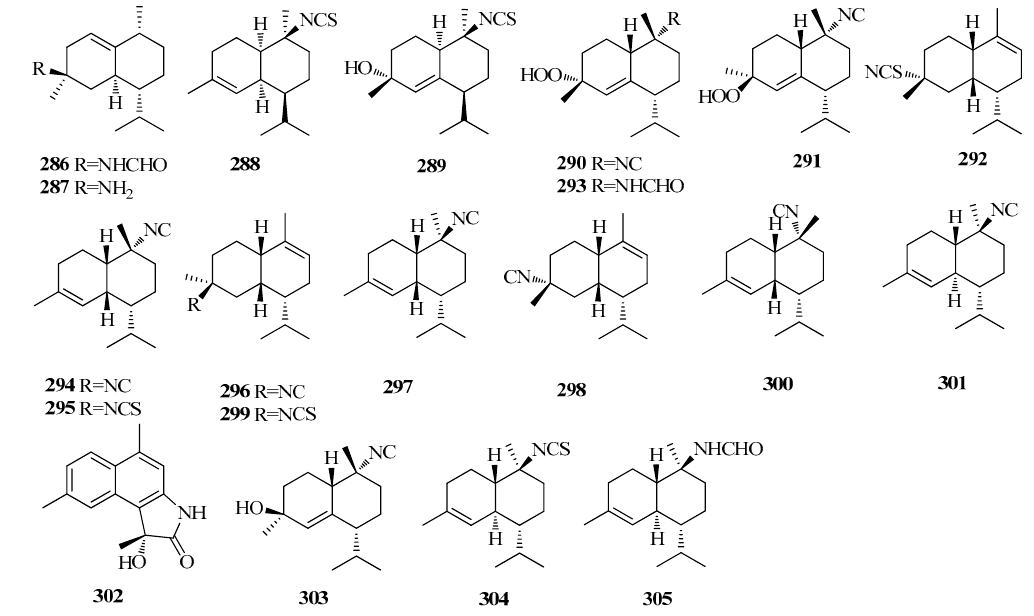
Figure 6. The structures of compounds 286 – 305.